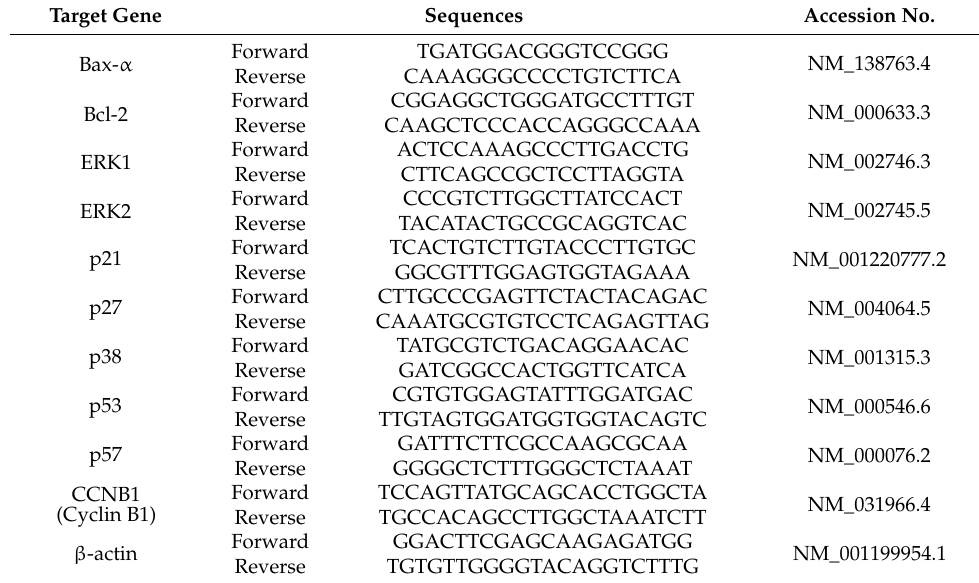
Table 1. Nucleotide sequence of primers and expected size of PCR